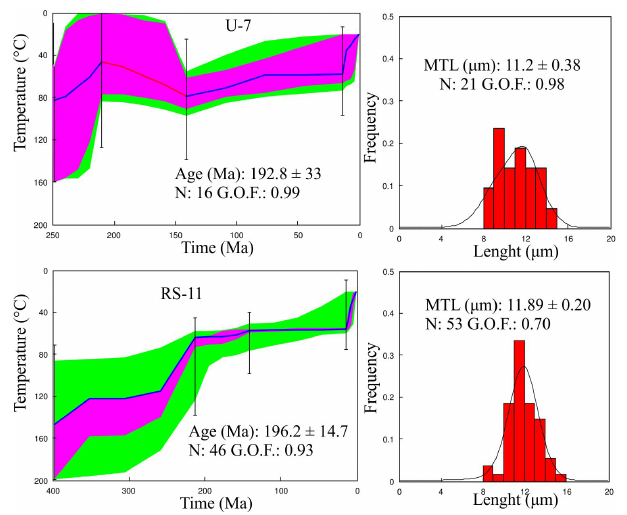
Figure 4. Thermal history of samples from the Central Domain. For detailed description see caption of Fig.